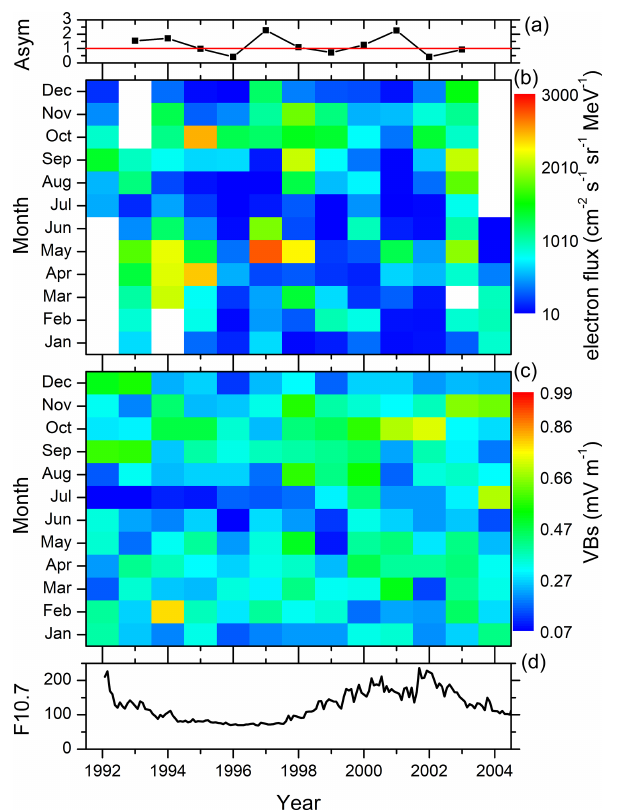
Figure 2. From top to bottom, the panels show Lomb–Scargle pe- riodograms of F10.7, V sw and D500, V B s , and 1.5–6.0MeV elec- tron fluxes at different L shells. The x axis shows periods in year, and the y axis shows the normalized amplitudes in arbitrary unit. Confidence levels of the periodograms are shown in each panel by horizontal lines.